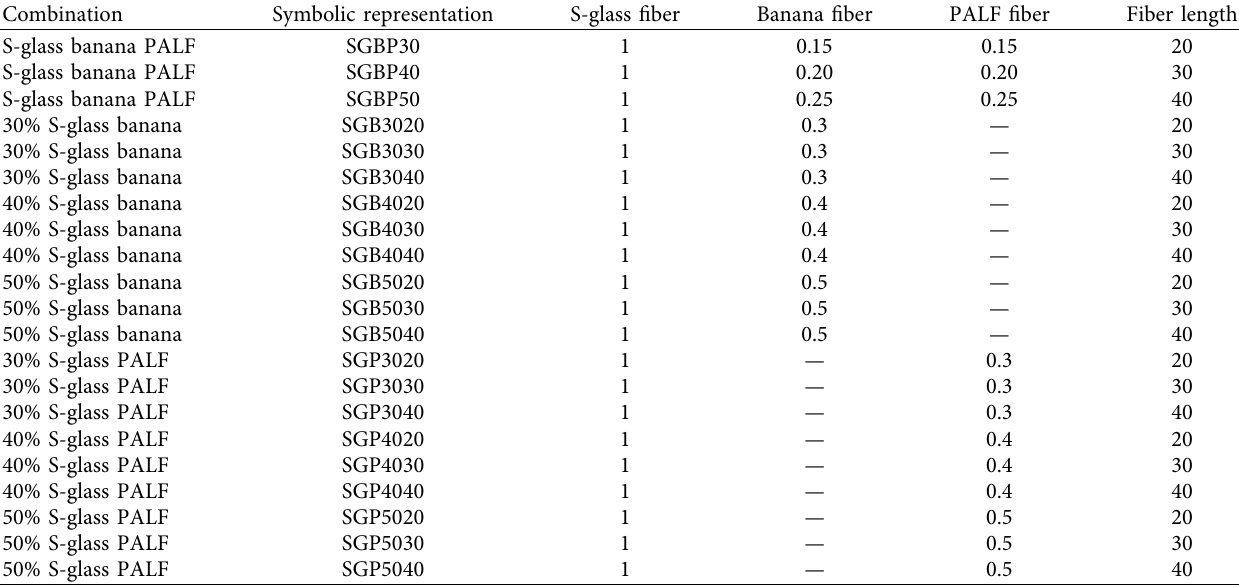
Table 2: Prepared samples of the hybrid composite.